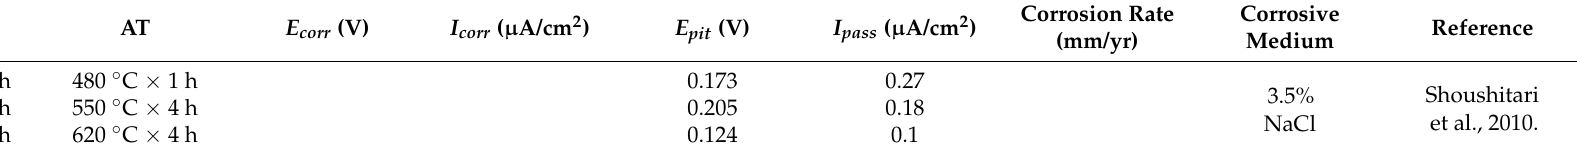
Table 4. Corrosion properties of PHSS after various heat treatment processes